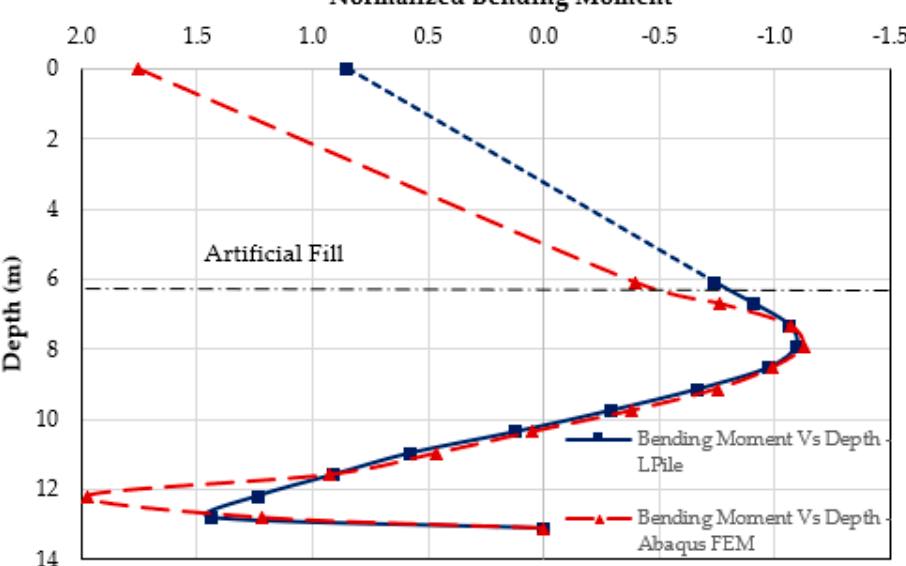
Figure 9. Validation of bending moments-L-pile and Abaqus FEM.